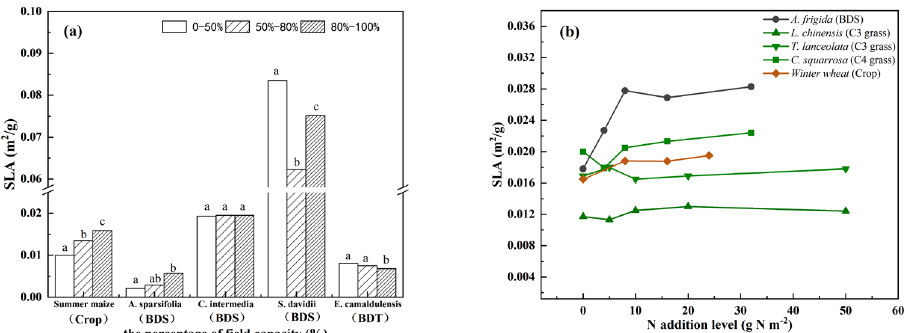
Figure 8. The SLA values of different PFTs under three soil moisture regimes ( a ) and different N addition levels ( b ). The different lowercase letters indicate significant differences at 0.05 level. More details about the species can be found in TableS2 [58-65].